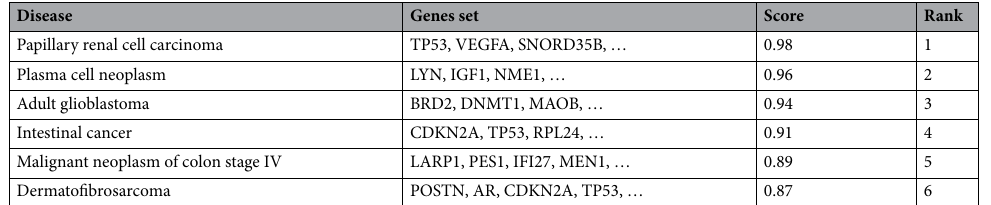
Table 3. An example of the output of the scoring S component. The first column is the name of the group disease, the Gene Set is the genes associated with the disease, the Score column is the computed score computed by the S component, and the Rank is the rank of the group based on the value of the score.